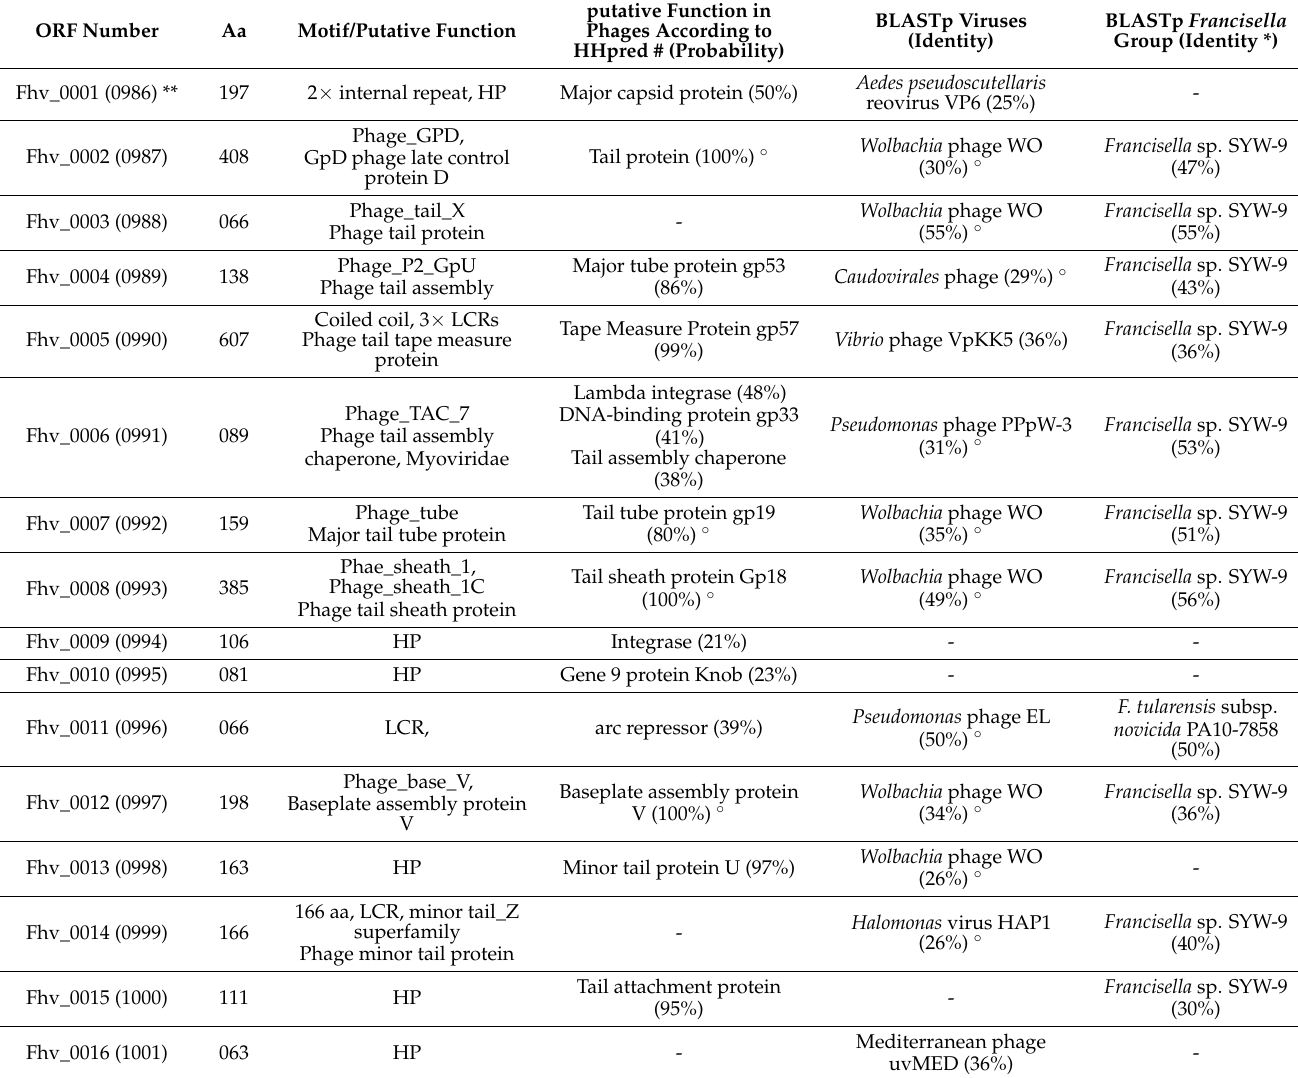
Figure 2. The putative origin of replication of vB_ FhiM _KIRK. The origin is composed of the putative inceptor signal for DNA replication (dotted lines, three times), found within a direct repeat sequence (arrows), and four misc-binding sites (underlined sequence). The region is localized within gene fhv_0043 (see Figure 1). Table 1. Putative proteins encoded by ORFs Fhv_0001 to Fhv_0051 of